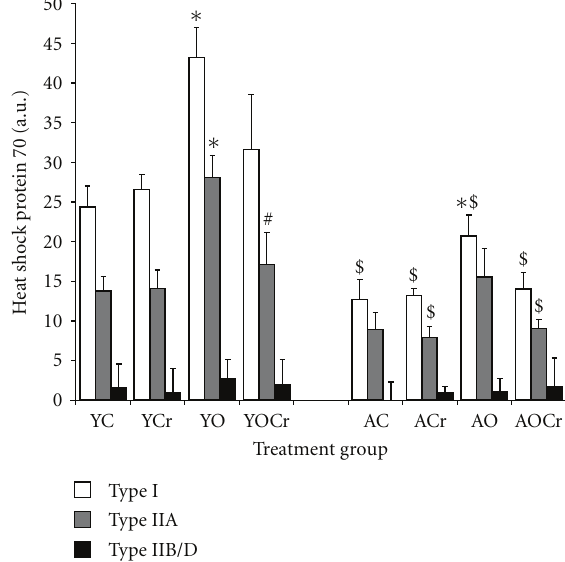
Figure 4: Heat shock protein for plantaris muscle in young and aging animals for all treatment groups. ∗ indicates significantly di ff erent than control within age group ( P < 0 . 05); # Indicates significantly di ff erent than surgical overload treatment within age group ( P < 0 . 05); $ significantly di ff erent than same treatment in young rats ( P < 0 .